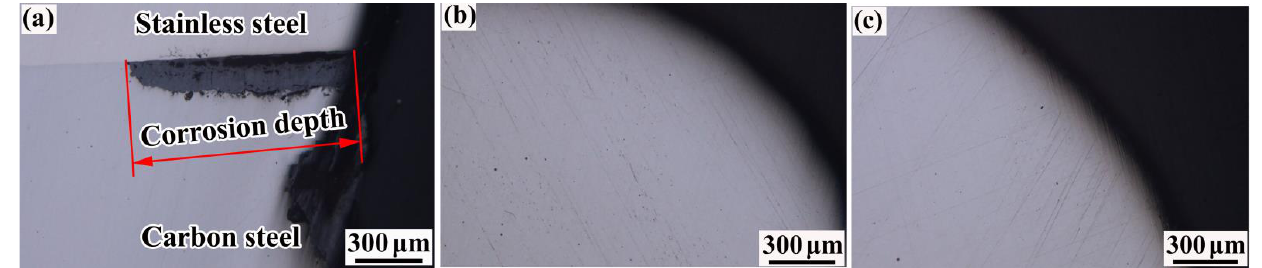
Figure 17. Corrosion depth of each joint after rust removal: ( a ) corrosion depth of sleeve, ( b ) corrosion depth of the bar-welded joint, and ( c ) corrosion depth of the groove-welded joint.